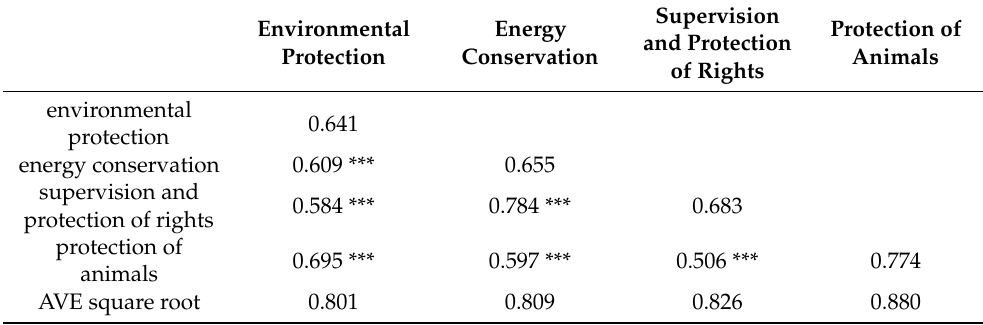
Table 7. Discriminant validity of social responsibility awareness.